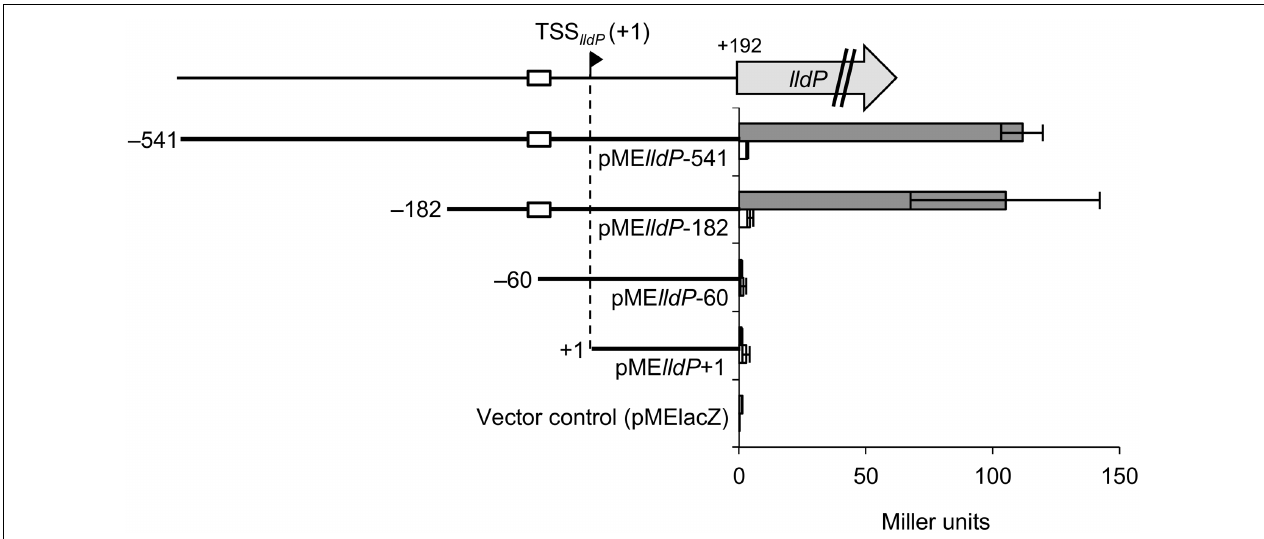
FIGURE 8 | 5 (cid:48) -deletion analyses of the upstream region of lldP . WT (gray bars) or (cid:49) crp (white bars) cells harboring the pME-series plasmids were grown on DL -lactate, and their LacZ activities were measured in the logarithmic growth phase. White boxes represent the putative CRP-binding motif. Error bars show standard deviations calculated from at least three independent